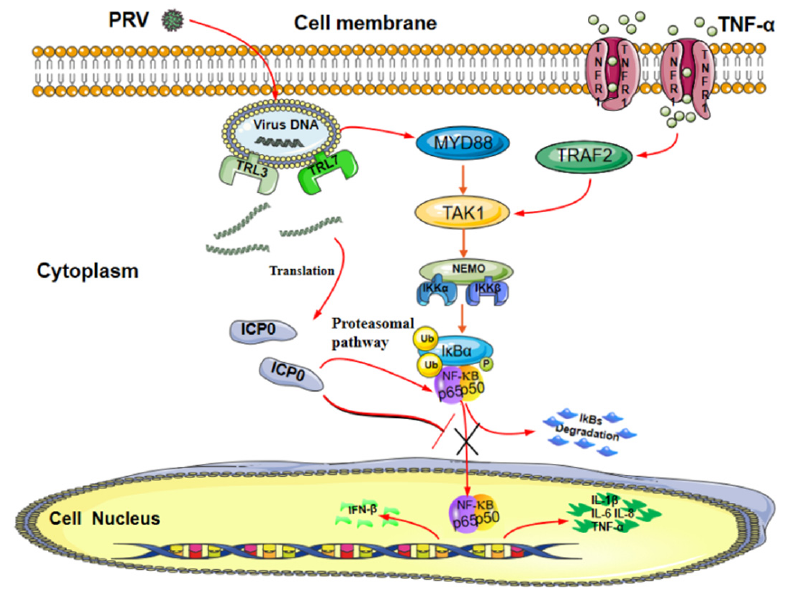
Figure 8. Model of ICP0 interfering with the NF- κ B signaling pathway. The PRV protein ICP0 blocks the degradation of I κ B α and inhibits its phosphorylation. Meanwhile, ICP0 interacts with p65 and degrades p65 protein expression via the proteasome pathway. In addition, ICP0 inhibits p65 phosphorylation and prevents its nuclear translocation, thereby negatively regulating the NF- κ B signaling